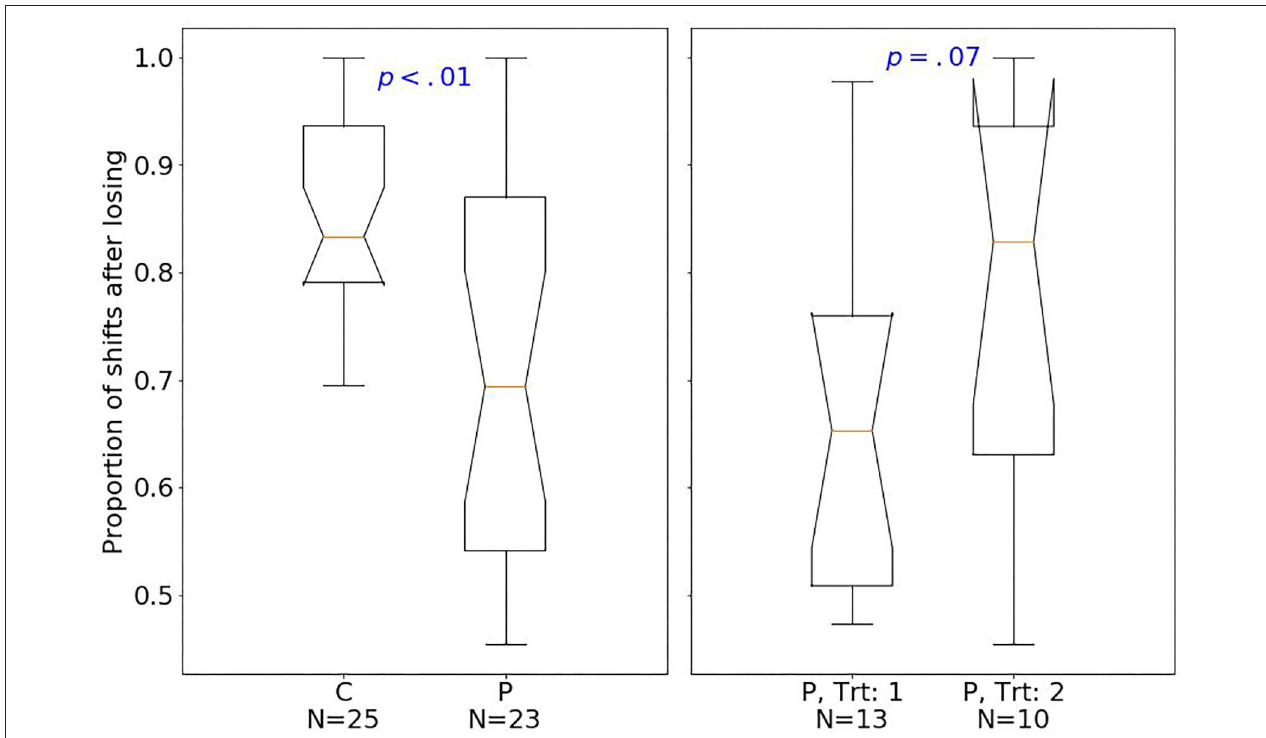
FIGURE 2 | Box plots of the PRL task. The horizontal line represents the median; the boxes extend to the first and third quartile, while whiskers extend to the max/min or the corresponding quartile + 1.5 IQR. C, healthy controls; P, patients with MUD; Trt_1, successful treatment outcome; Trt_2, unsuccessful treatment outcome. Box plots of proportion of shifts after